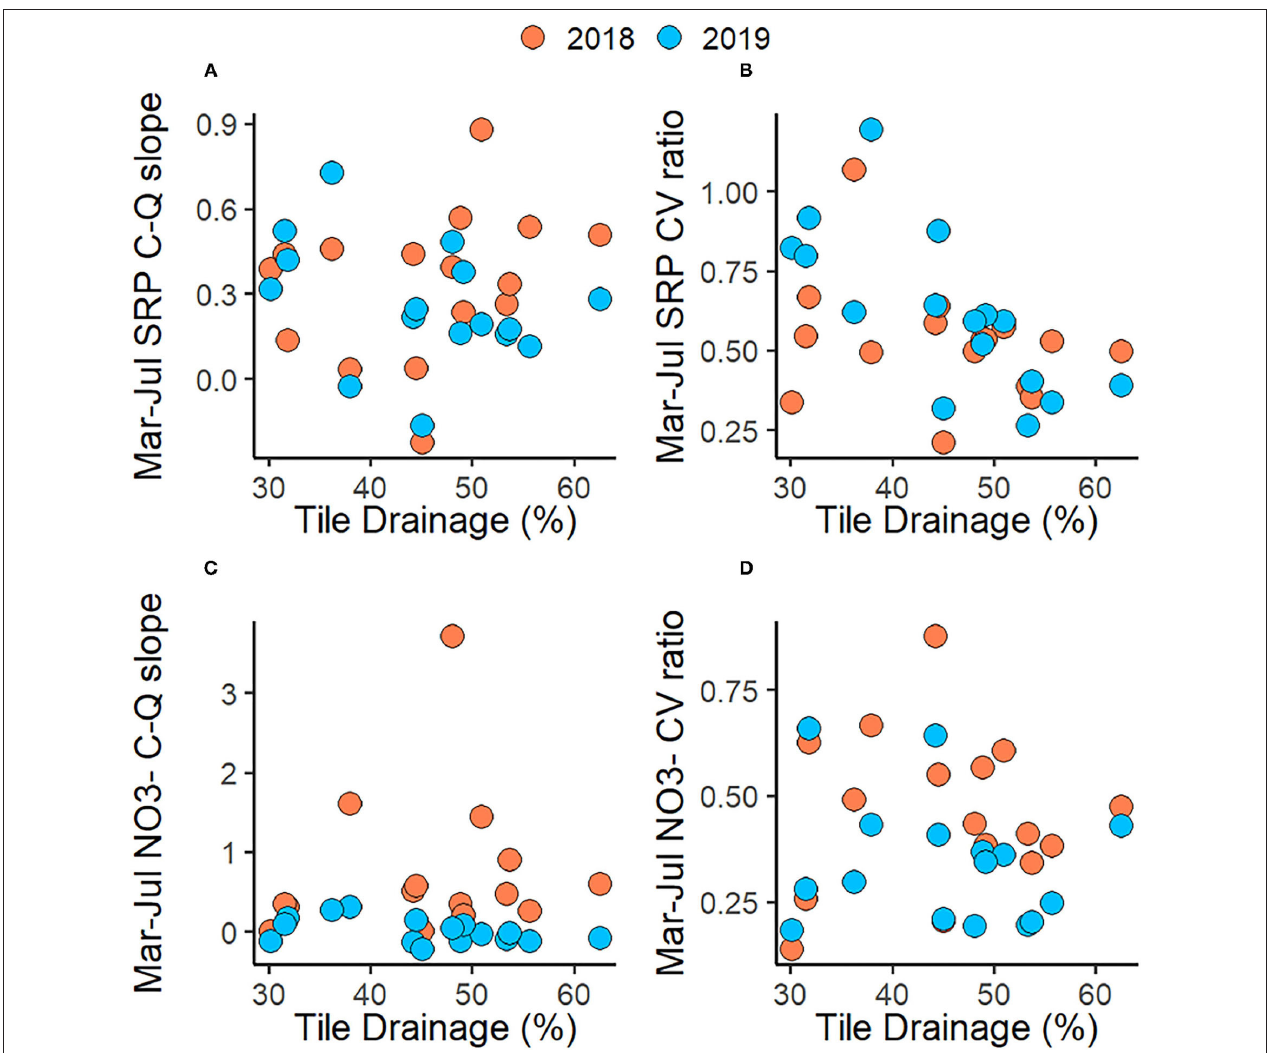
FIGURE 5 | March–July soluble reactive phosphorus (SRP) concentration-discharge (C-Q) slope ( A ; Pearson’s r = 0.27 and − 0.36, respectively) and coefficient of variation (CV) ratio ( B ; Pearson’s r = − 0.26 and − 0.72, respectively) vs. tile drainage during 2018 and 2019. March–July nitrate (NO − 3 ) concentration-discharge (C-Q) slope ( C ; Pearson’s r = 0.16 and − 0.46, respectively) and coefficient of variation (CV) ratio ( D ; Pearson’s r = 0.07 and − 0.17, respectively) vs. tile drainage during 2018 and